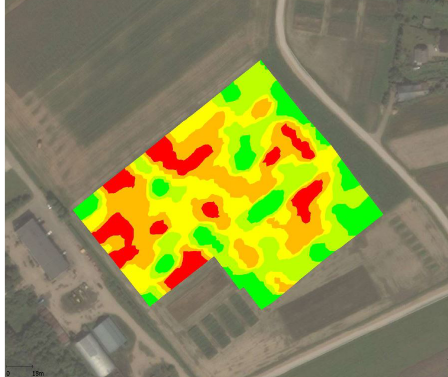
Fig. 3. Experimental site mapping with Veris 3150 MSP